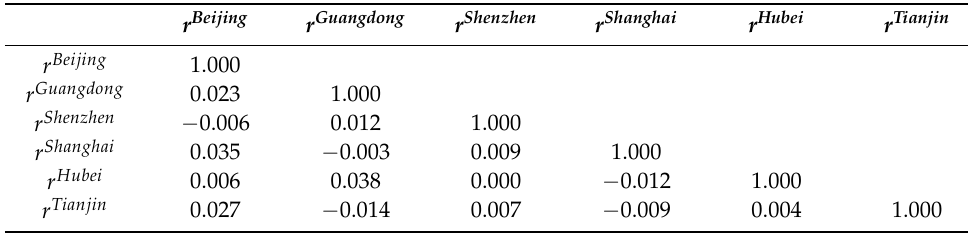
Table 2. Pairwise correlation matrix.